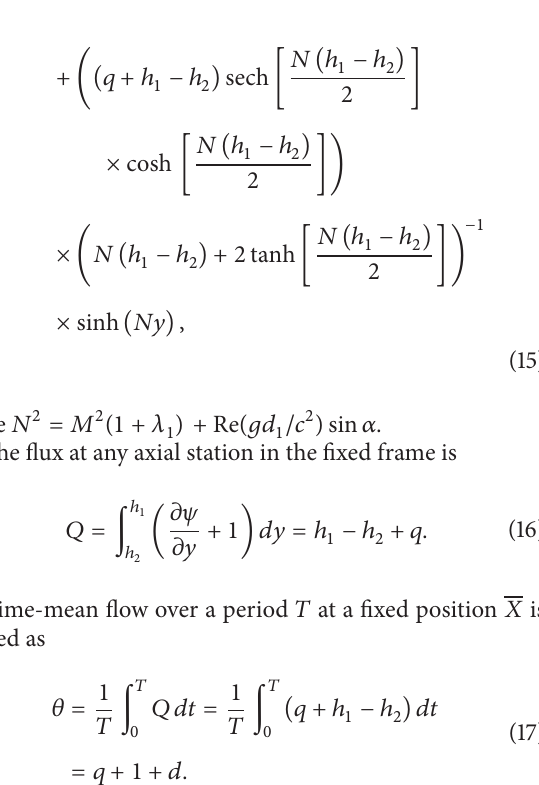
Figure 3: Variation of 𝑑𝑝/𝑑𝑥 with influence of Θ and 𝑔 respect to 𝑥